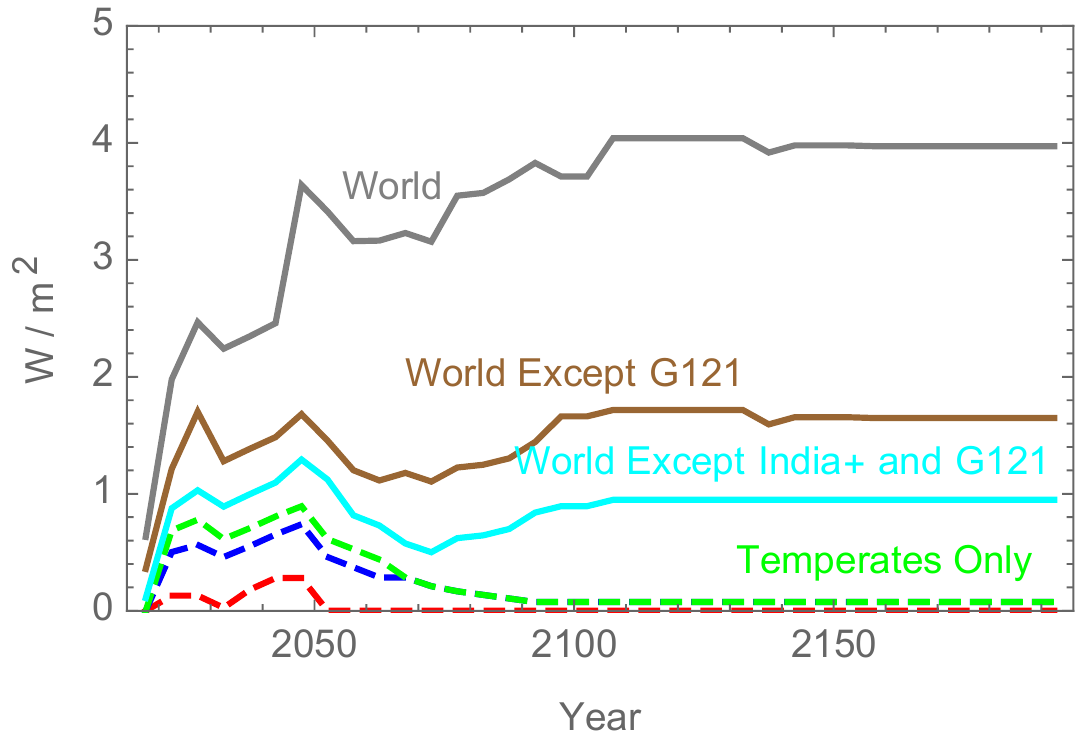
Figure 6. Solar radiation management by region. Included in curves from the lowermost upward are China+, USA+, EU+, Ocean, India+, and G121.